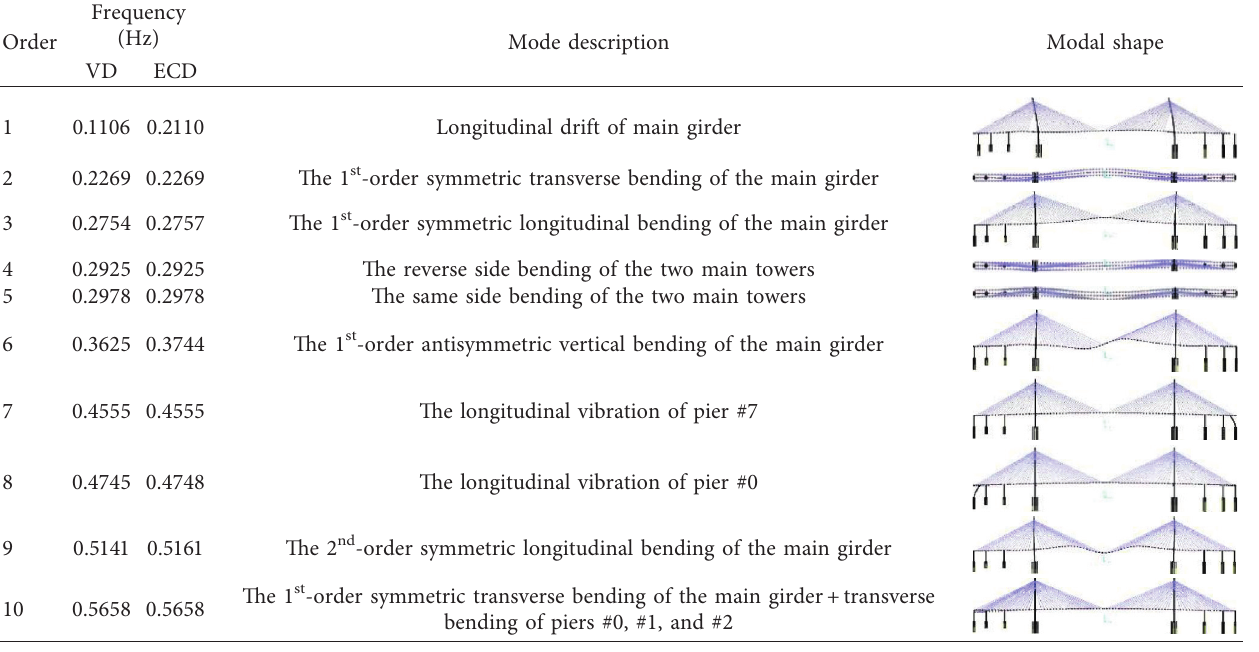
Table 2: Vibration frequencies and the corresponding modal shapes of the